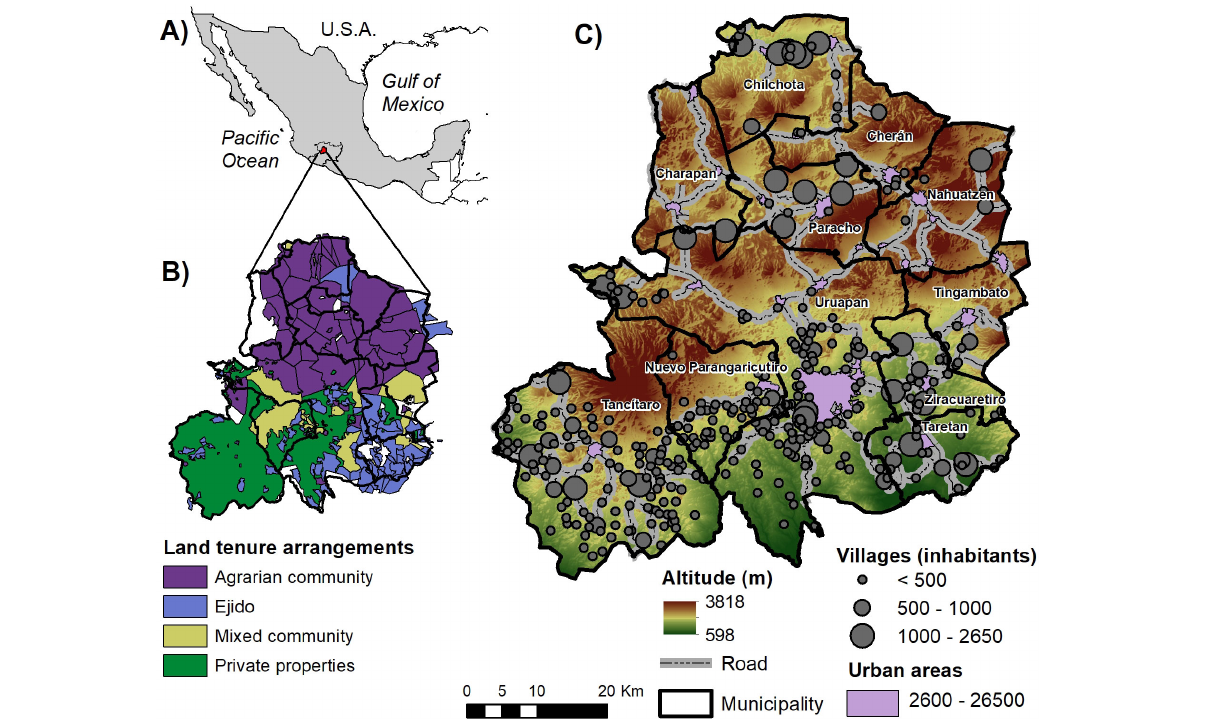
Fig. 1 . Study area: (A) macro location, (B) land tenure arrangements, and (C) geographical